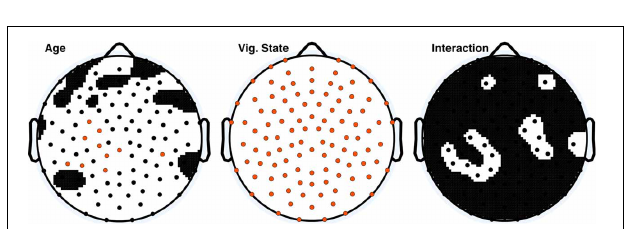
FIGURE 2 | ANOVA p -value distributions; electrodes with factor effect p -values less than 0 . 05 are those displayed in black on the white background. Electrodes with significant p -values following Holm–Bonferroni correction are depicted in orange. The nasion electrode (not shown) was significant for the vigilance state effect post-hoc , and was not significant at any level for the other